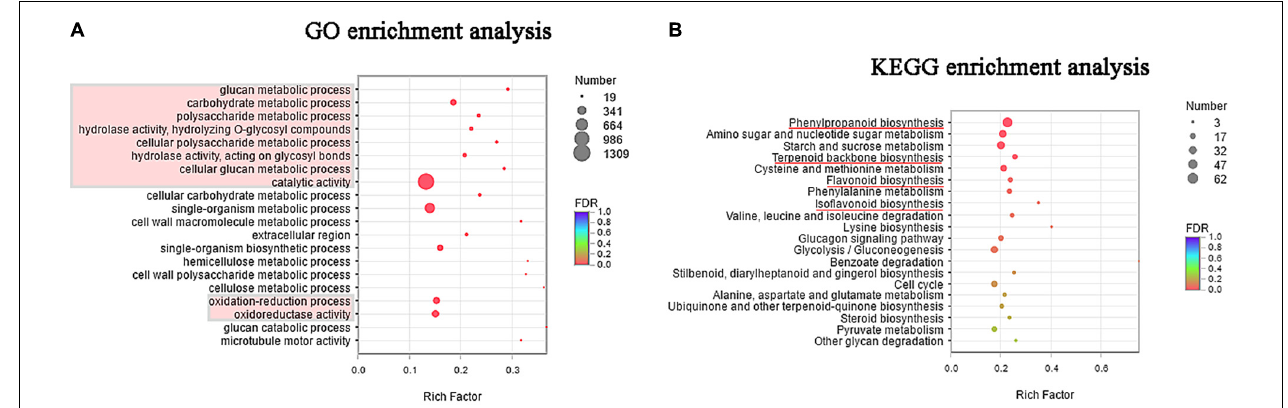
FIGURE 3 | (A) Gene ontology (GO) enrichment of top 20 terms between salt-stressed and control groups. (B) Kyoto Encyclopedia of Genes and Genomes (KEGG) enrichment of top 20 pathways between salt-stressed and control groups.